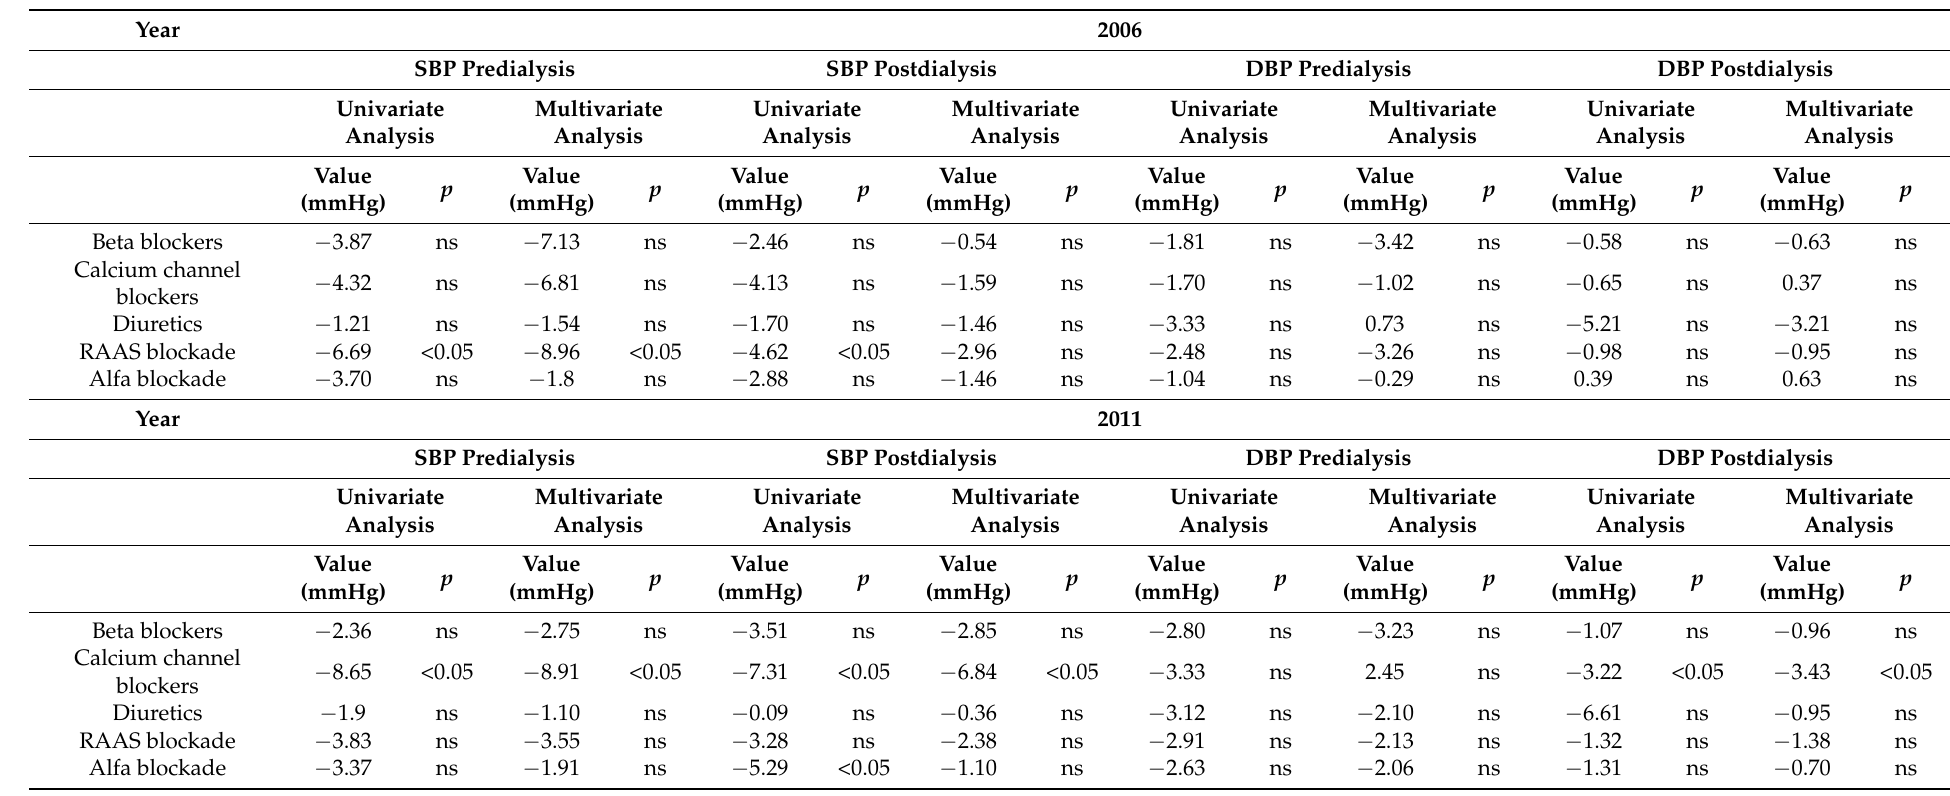
Table 5. The influence of hypertensive drugs for the value of blood pressure in the study population (linear